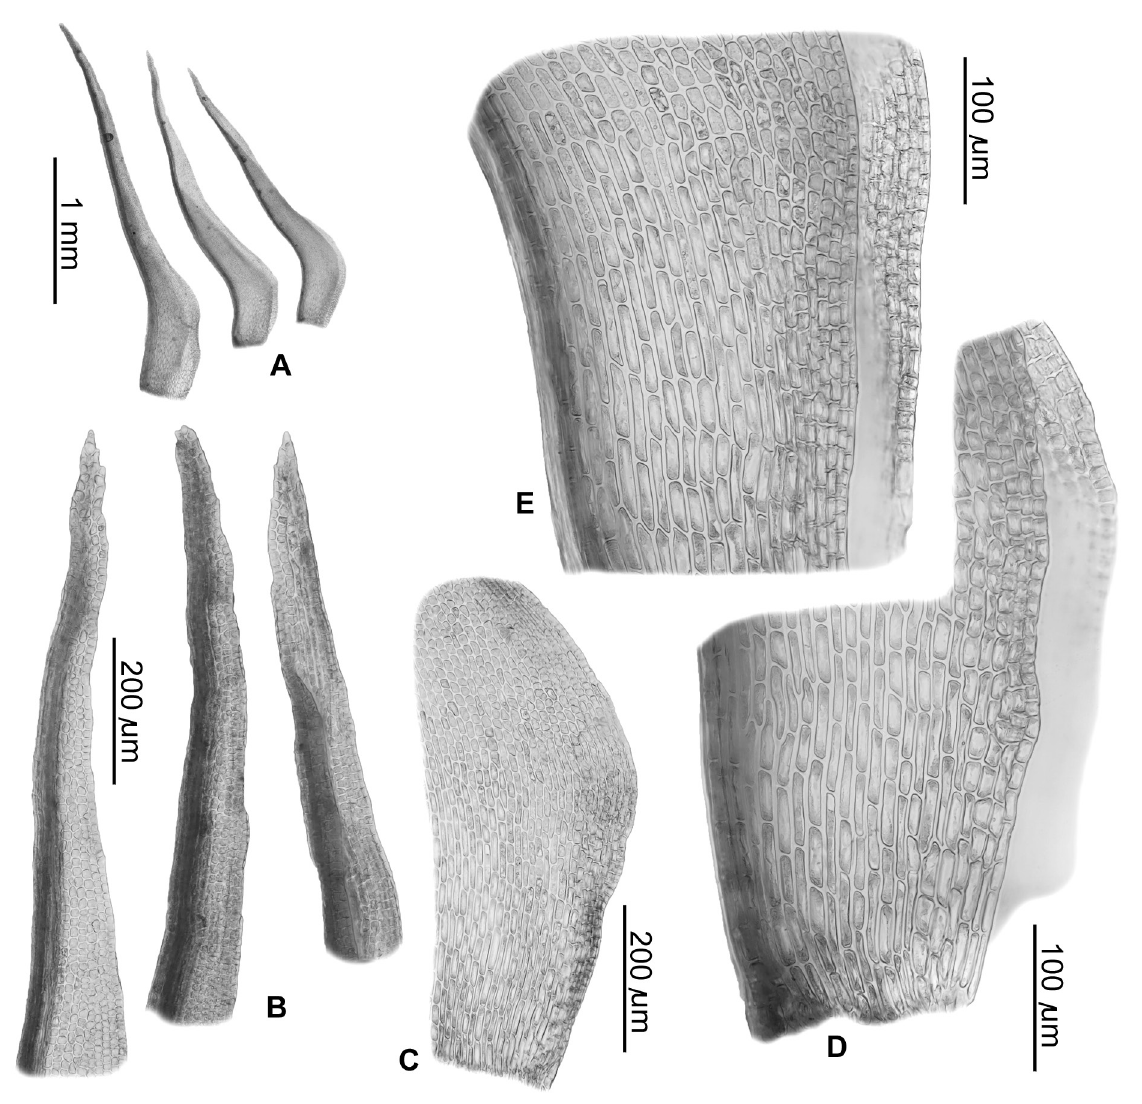
Fig. 7. Oncophorus wahlenbergii A (specimen P225; cf., Table 1). A . Stem leaves. B . Upper leaf acumen. C . Portion of leaf at widest point, showing the flat margin. D, E . Sheathing leaf portions, showing short marginal leaf cells (margin to the right) and, in D, alar